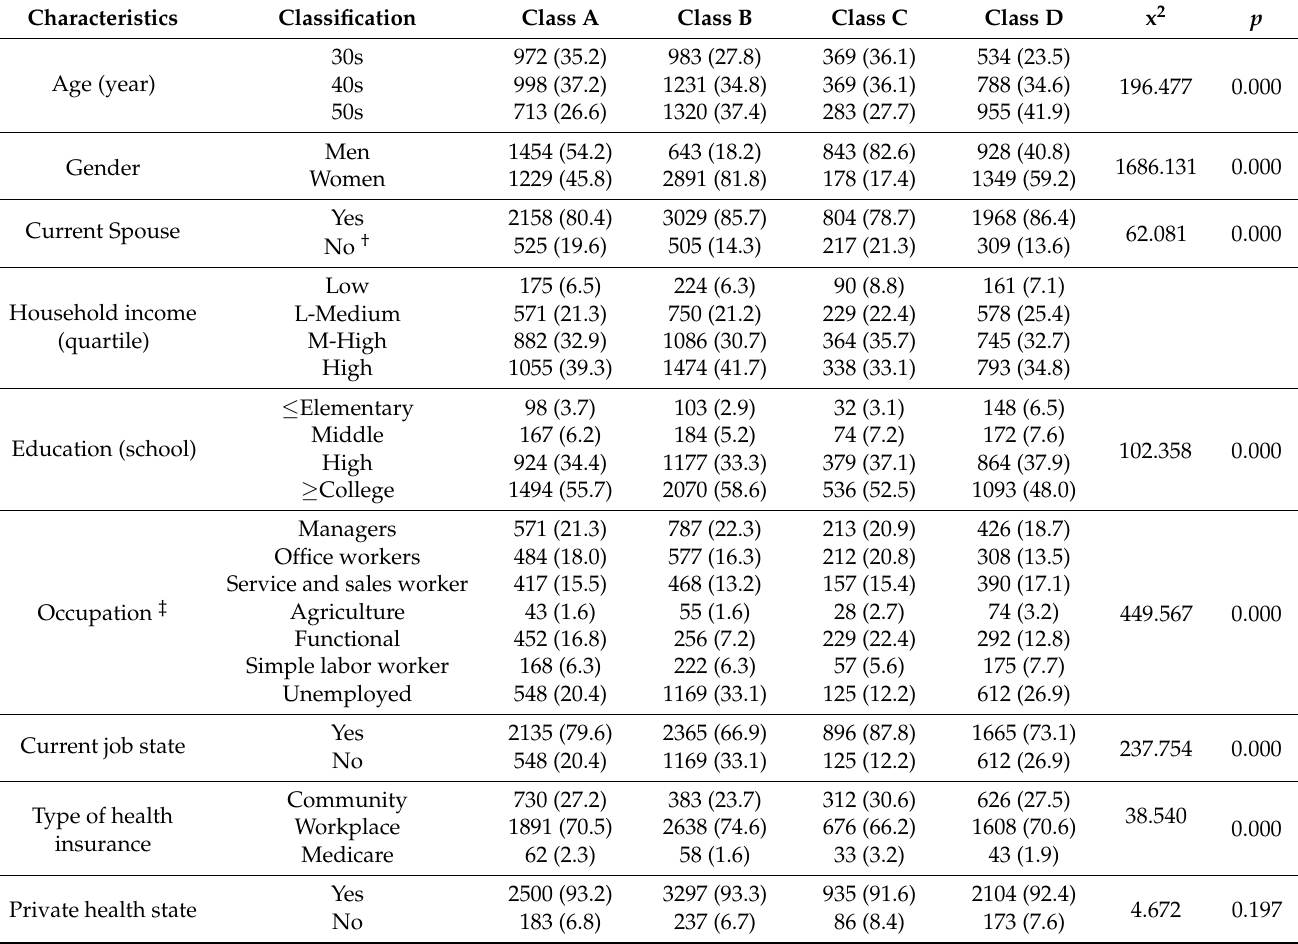
Table 3. Differences in the general characteristics of the four latent